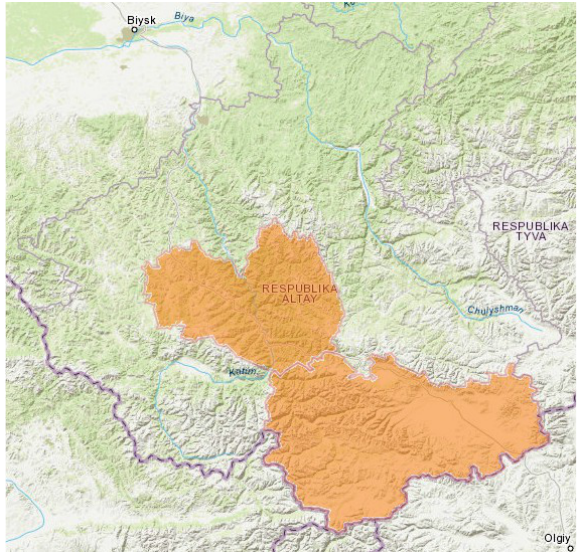
Figure 1 . Ongudaysky and Kosh-Agachsky Districts of the